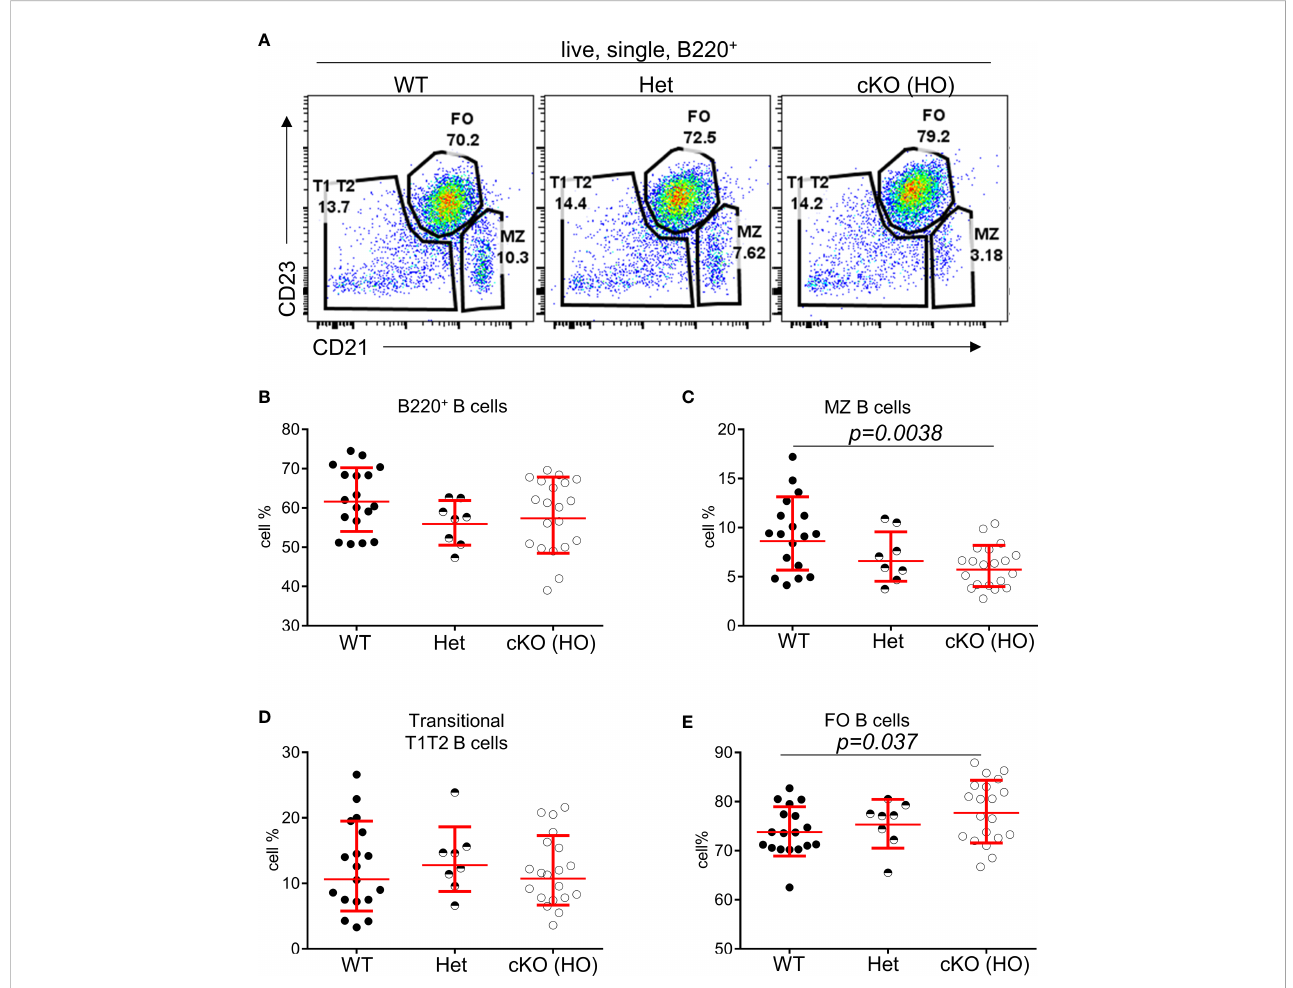
FIGURE 1 Reduced percentages of MZ B cells in Gtf2i cKO mice. (A) Representative plots of splenic B cell immunophenotyping of WT, Gtf2i fl /+ CD19-Cre+ (Het) and Gtf2i fl / fl CD19-Cre+ (HO) mice. FACS dot plots of CD21 (x axis) and CD23 (y axis) expression in B cells show CD21 lo CD23 hi Follicular (FO) B cells, CD21 hi CD23 lo Marginal Zone (MZ) B cells and CD21 lo CD23 lo Transitional (T1T2) B cells. (B) Splenocytes of wild type (WT), heterozygous (Het) and homozygous null (HO) mice were stained with B220 antibody and the percentages of B220+ total B cells are shown. (C – E) Primary splenic B cells were isolated from WT, Het and HO mice using EasySep magnetic puri fi cation techniques by negative selection. About 1 million B cells were stained with anti CD21-FITC and anti CD23-PE for 35 minutes, then washed and analyzed at the BD FACSAria Fusion. The percentages of FO, MZ and T1T2 B cells from 18 - 20 independent experiments are shown. Signi fi cance (P values) were calculated using paired student ’ s t test in Graphpad